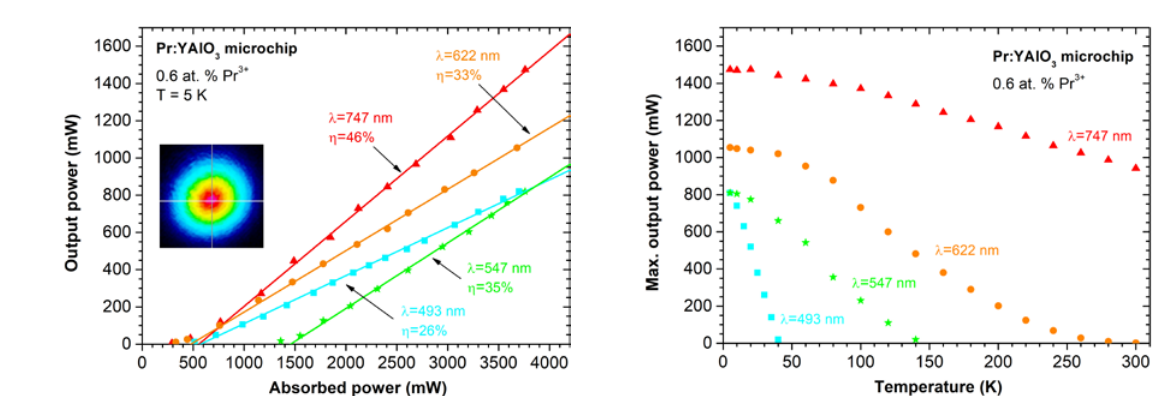
Fig. 1. Output characteristics of Pr:YAP microchip lasers designed for generation in near-infrared, orange, green, and cyan-blue laser transitions at 5 K crystal temperature; inset – spatial beam profile at maximal output power for illustrative purposes.